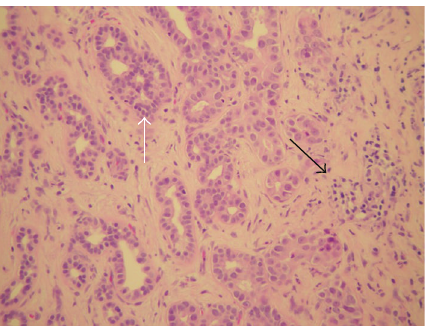
Figure 3: High-grade dysplasia with epithelial tufting and cellular atypia (white arrow). Microscopic focus of invasive carcinoma (black